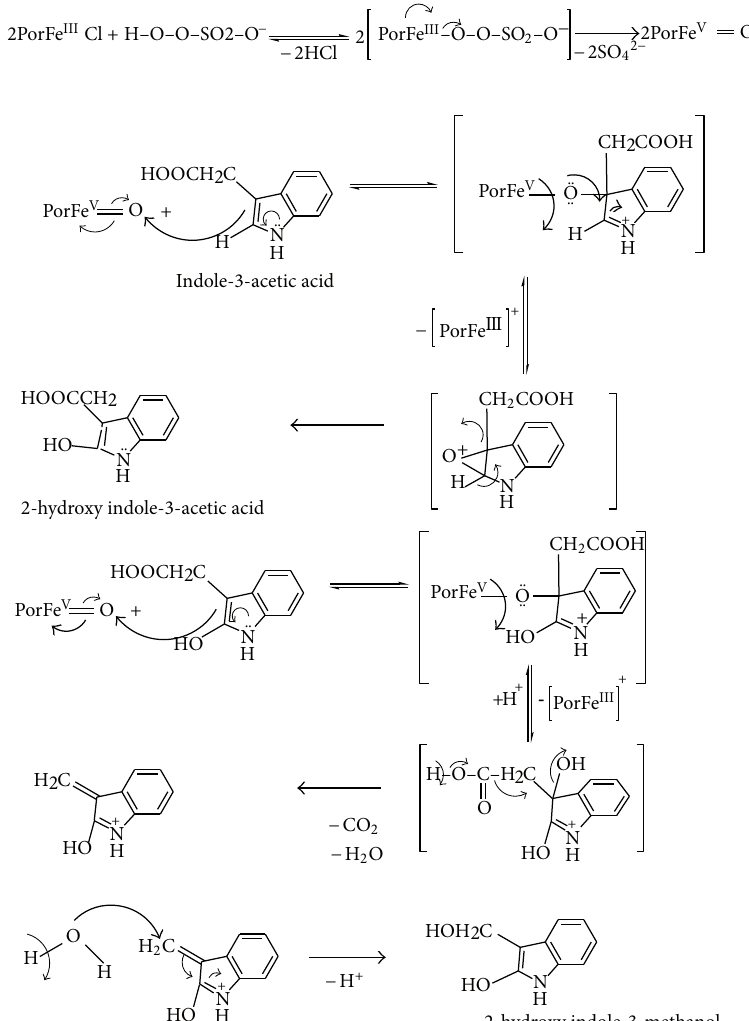
S 2: Probable mechanism for the high concentration of meso -tetraphenylporphyrin iron(III) chloride catalysed oxidation of indole by